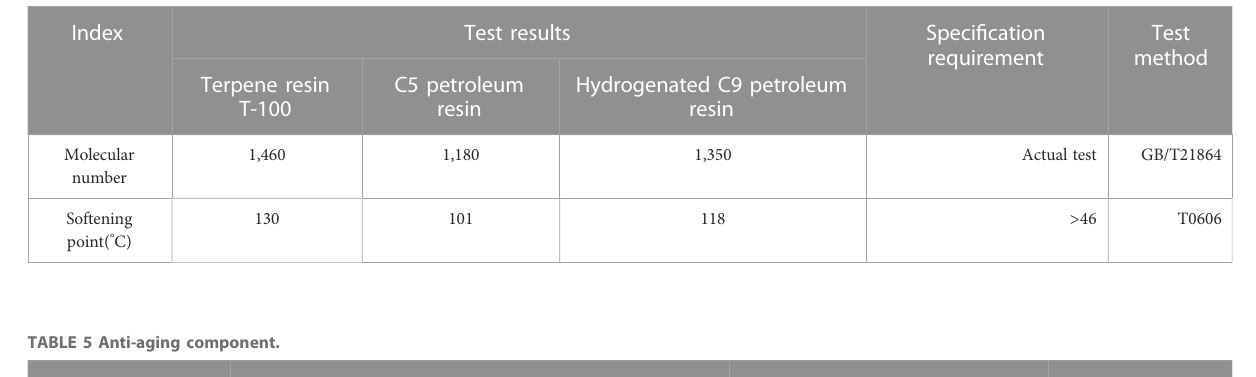
TABLE 4 Tacki fi er component.